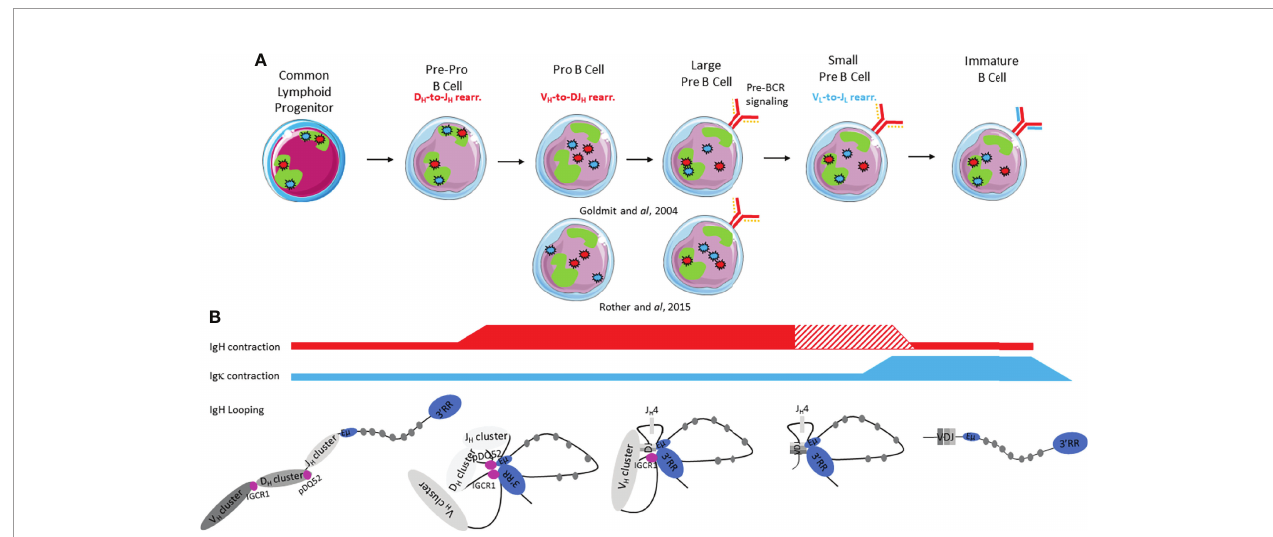
FIGURE 3 | Immunoglobulin loci contraction, conformation, heterochromatin addressing and nuclear positioning during early B cell development. (A) IgH and IgL alleles are respectively represented by red stars and blue stars; the green form represents the pericentromeric heterochromatin compartment (PCH). The pre-BCR is represented by a continuous red line and a discontinuous orange line (surrogate light chain). The BCR is represented by continuous red and blue lines. (B) Ig loci contraction is shown by red and blue lines for IgH and Igk respectively: thickness of the line indicates degree of contraction. The hatched lines correspond to controversial